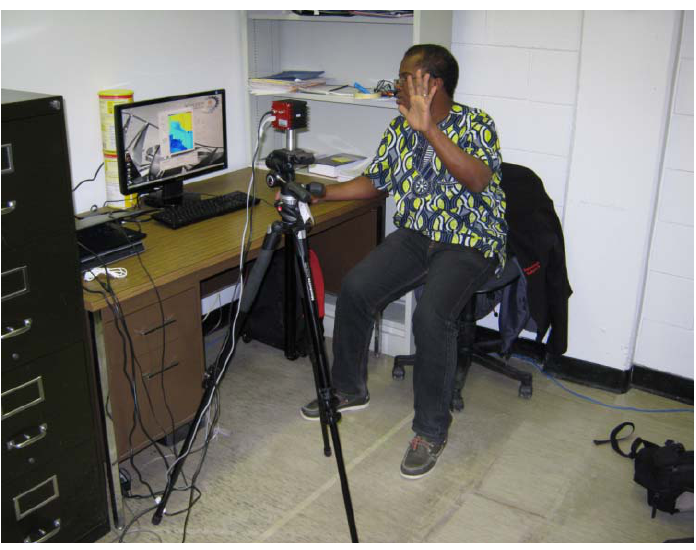
Figure 2. Experimental setup.